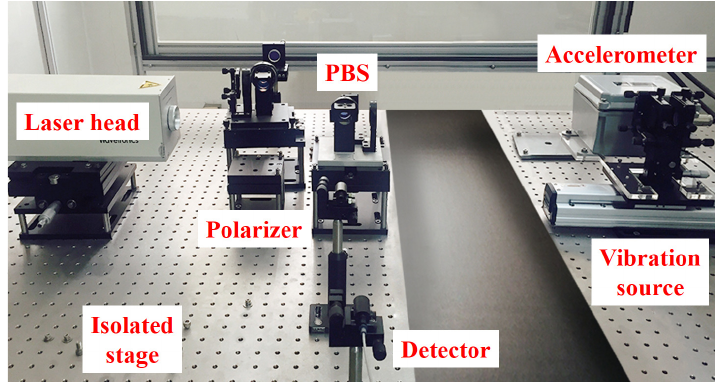
Figure 4. Seismic wave measurement using a laser